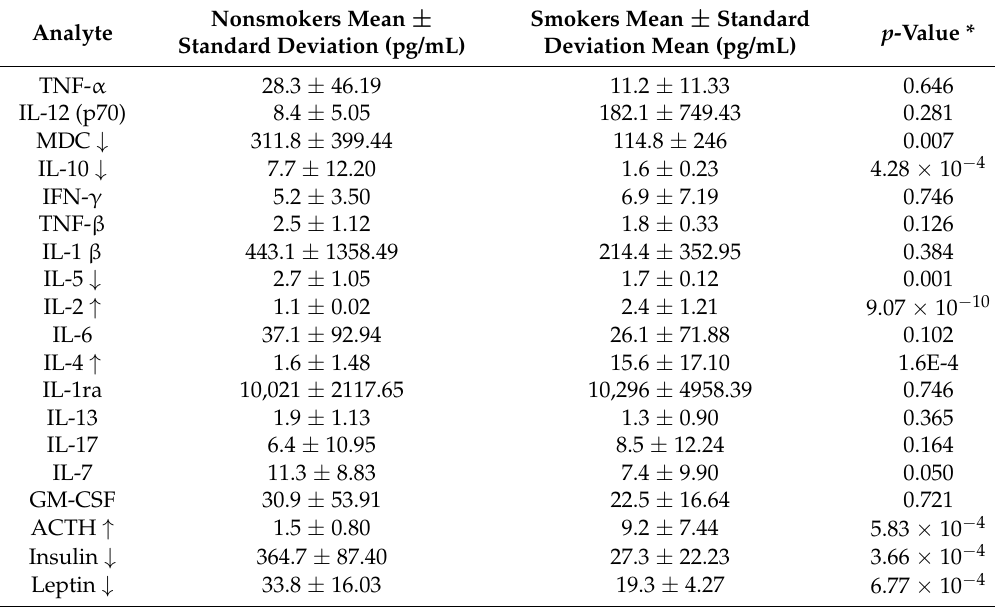
Table 2. Analytes in saliva samples from smokers and